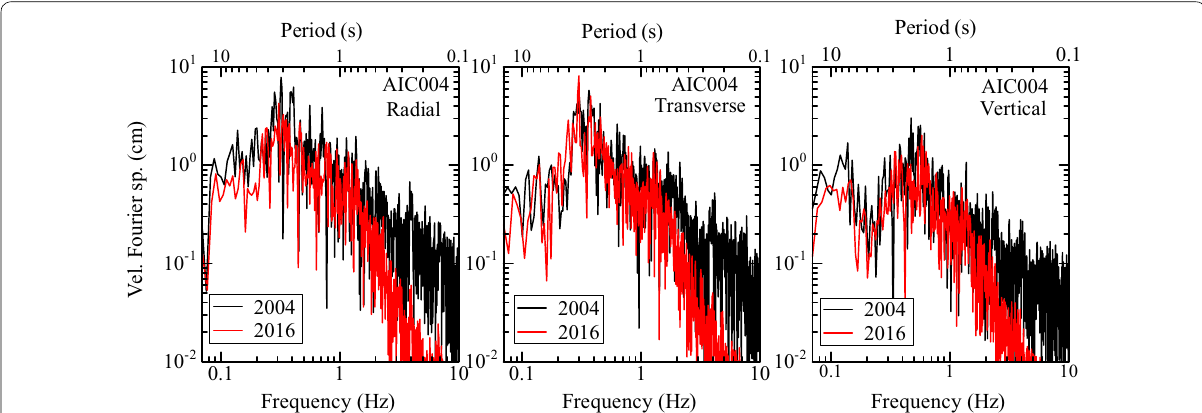
Fig. 5 Plot of radial (left panel), transverse (middle panel), and vertical (right panel) component velocity Fourier amplitude spectra at site AIC004 (see Fig. 1 for location) for the 2004 (black) and 2016 (red) events. See Fig. 4 for the velocity seismograms at the site